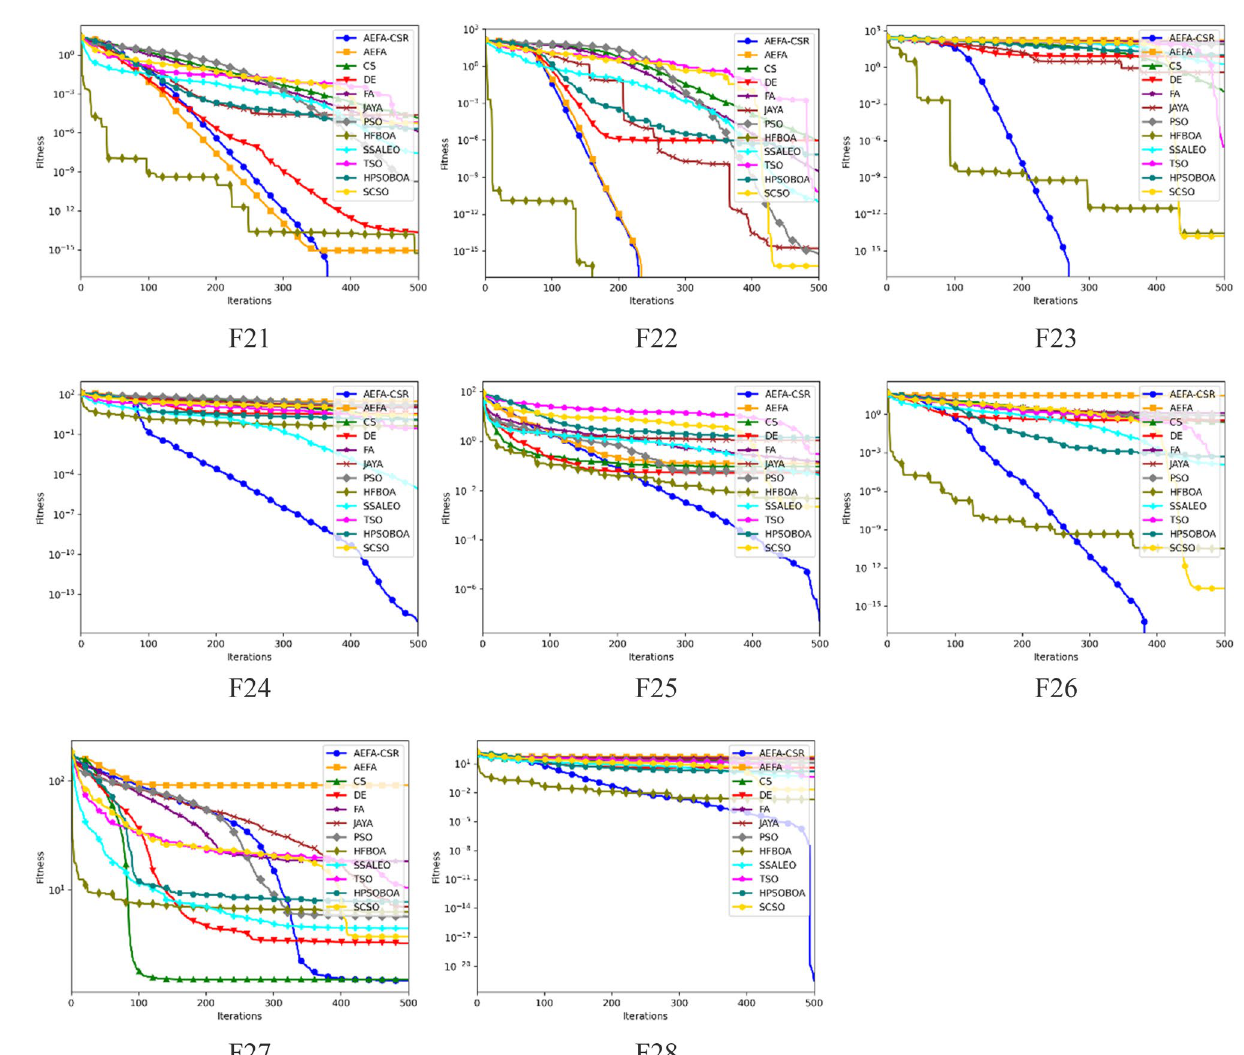
Figure 6. Convergence trajectory values for F21-